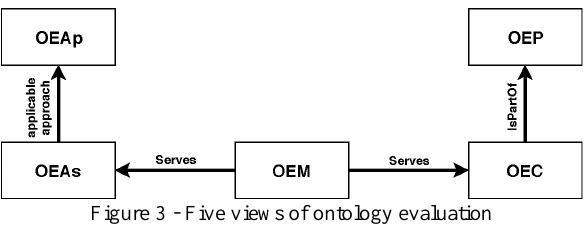
Figure 3 - Five views of ontology evaluation